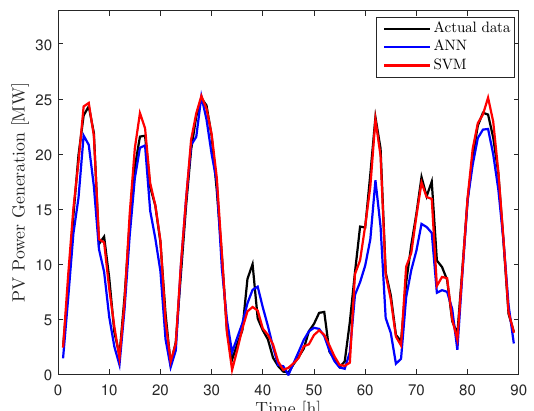
Figure 3. Results of PV power prediction of day time for eight consecutive